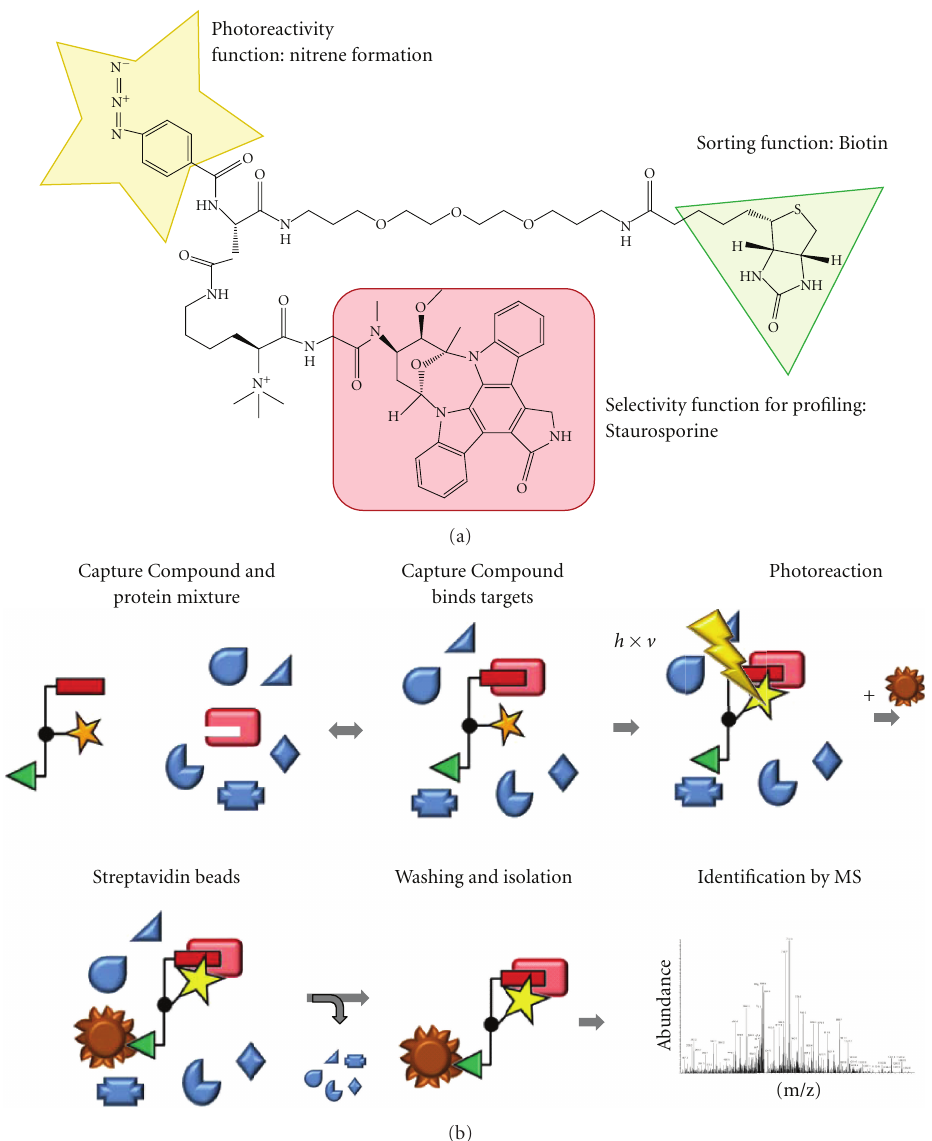
Figure 1: The molecular structure of staurosporine Capture Compound (a) and schematic representation of the capture process (b).